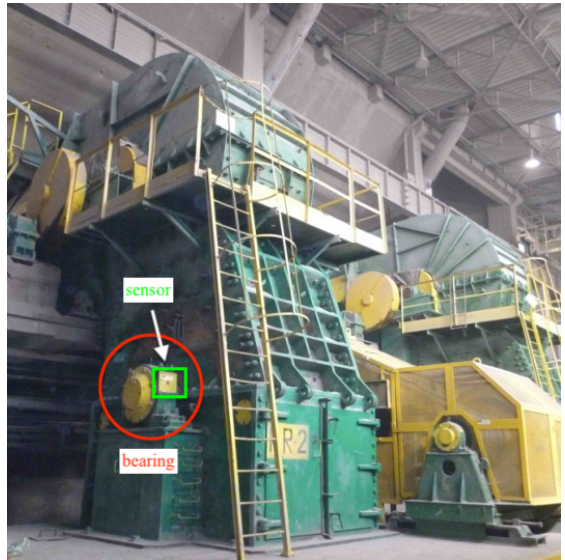
Figure 38. Hammer crusher with bearing and sensor locations